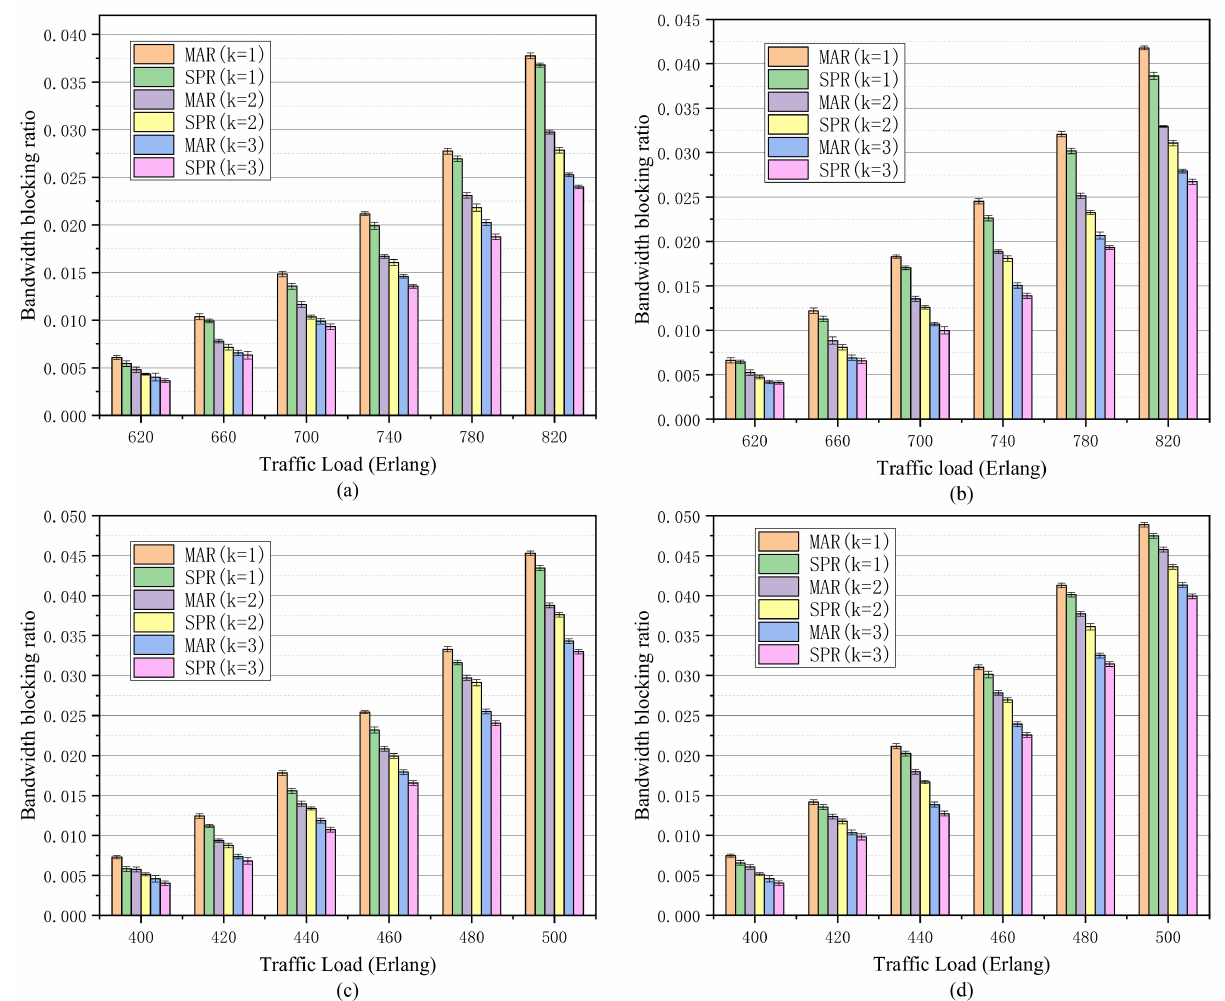
Figure 4. Simulation and results. ( a ) BBR under uniform traffic model when 8 nodes are upgraded in USNET; ( b ) BBR under non-uniform traffic model when 8 nodes are upgraded in USNET; ( c ) BBR under uniform traffic model when 5 nodes are upgraded in NSFNET; ( d ) BBR under non-uniform traffic model when 5 nodes are upgraded in